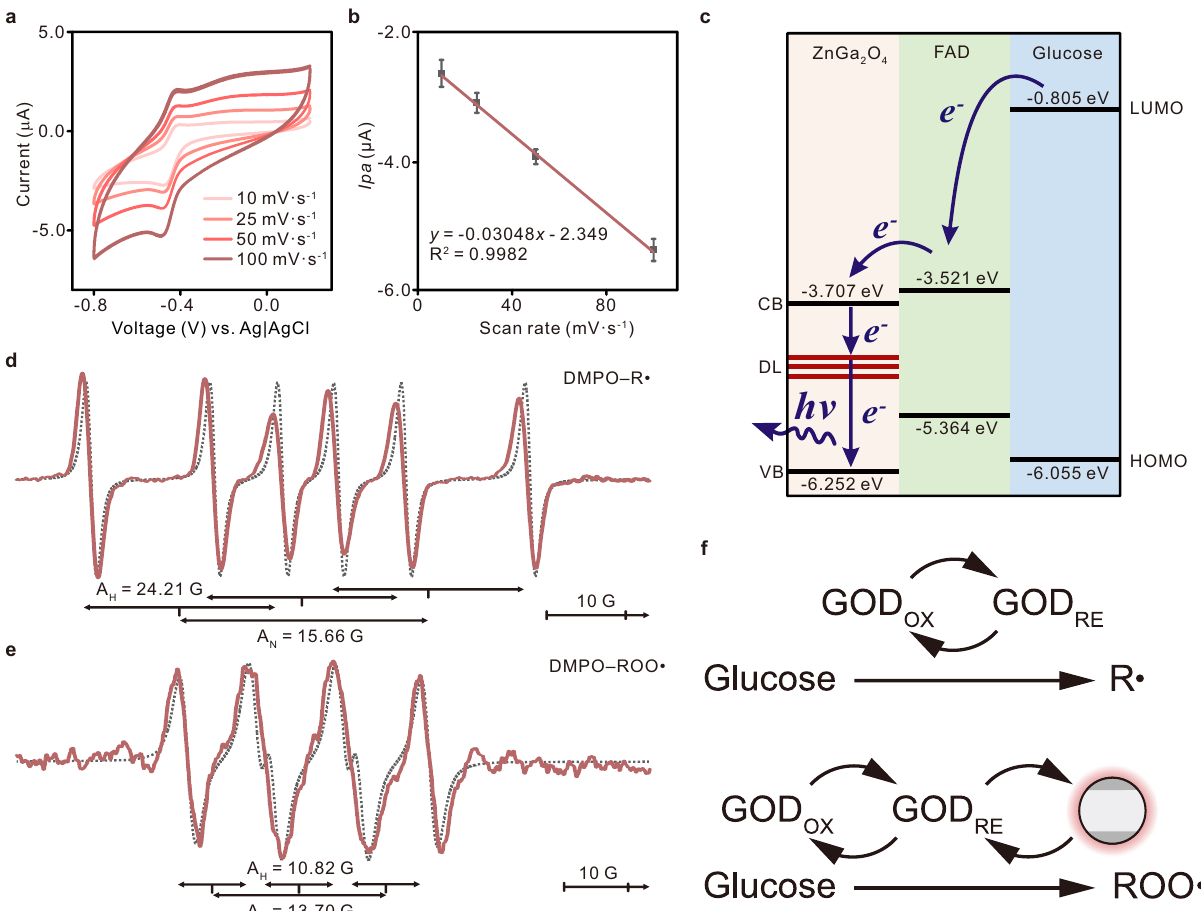
Fig. 3 Electron transfer between ZnGa 2 O 4 and target molecules. a Voltammograms of GOD/ZnGa 2 O 4 -coated electrodes of a PBS solution at different scan rates (10 – 100 mV·s − 1 ). b Extracted oxidation peak current (ip) mean values (circles) from the voltammograms shown in a plotted versus the scan rate ( n = 3 independent electrodes). Error bars in all graphs represent the s.d. of the mean values. c The energetic structure of the system, as determined by density functional theory (DFT) calculations (Supplementary Figs. 3 – 6). FAD, fl avin adenine dinucleotide; CB, conduction band; DL, defect level; VB, valence band; LUMO, lowest unoccupied molecular orbital; HOMO, highest occupied molecular orbital. d EPR spectrum of glucose and GOD